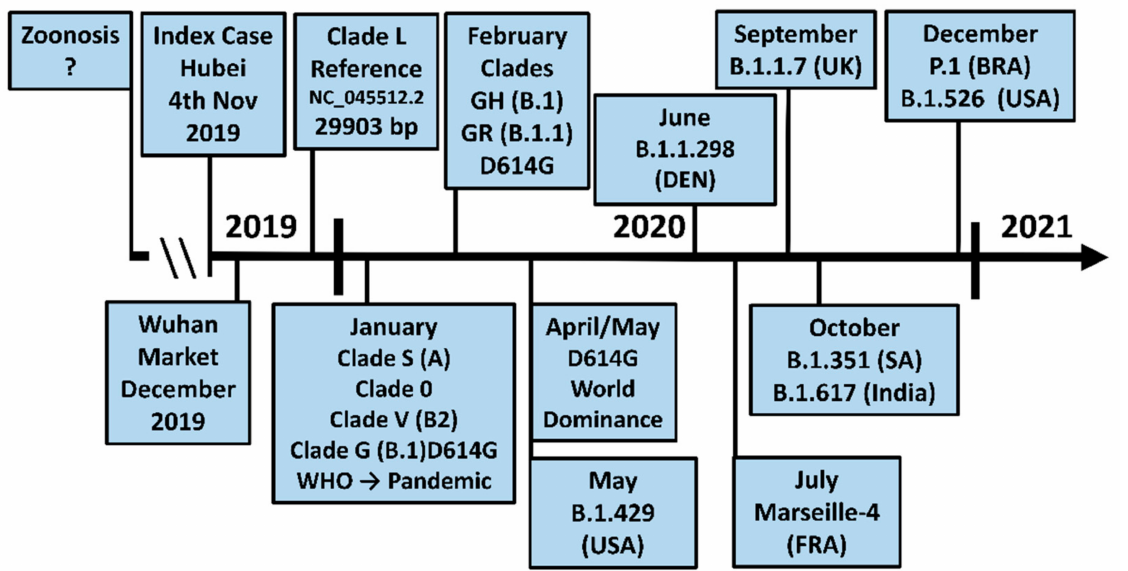
Figure 2. Timeline of the SARS-CoV-2 pandemic and the emergence of the variants. See text for further details. Although the substitution of the negatively charged aspartate-614 by the uncharged and smaller glycine (D614G) removes a salt bridge with lysine-854 (K854) and a bond with T859, both in another spike protomer of the trimer, the overall structural changes in spike itself are limited to a loop (620–640 aa) close to its furin site. This loop is